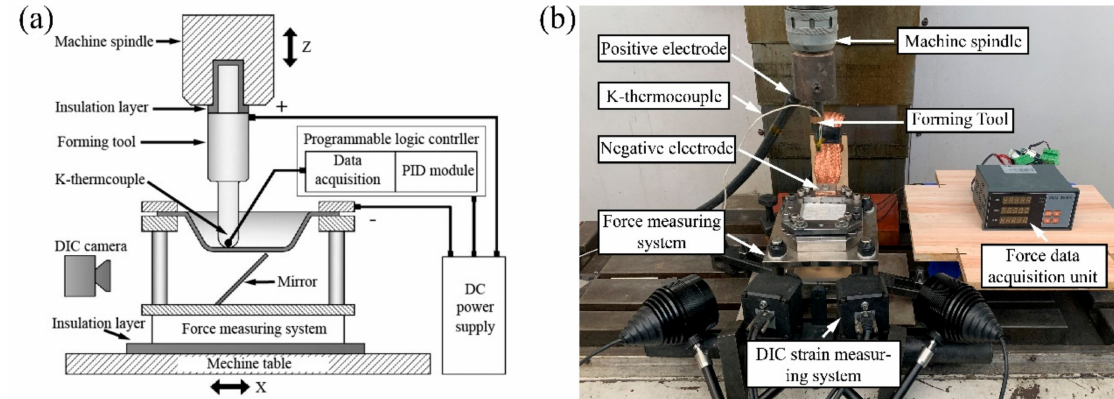
Figure 2. Experimental equipment of EHIF: ( a ) schematic structure, ( b ) actual setup. The tool path was controlled by the NC program in the FANUC system as shown in Figure 3a. The horizontal and vertical feeds of the machine corresponded to the X and Z directions, respectively. The length of the straight groove was 60 mm and the processing parameters were a step size of 0.2 m, a feed rate of 500 mm/min and a tool diameter of 8 mm. The target temperatures of the tool were set to 100 ◦ C, 150 ◦ C, 200 ◦ C, 250 ◦ C, 300 ◦ C and 350 ◦ C. The experiment was repeated three times under each condition. In order to study the temperature variation during the machining path, the actual temperature of the plate was measured at point A, B and C, as shown in Figure 3b, to compare with the target tool temperatures. Based on the digital image correlation (DIC) strain measuring system (Module XJTUDIC, Xi’an, China), the strain distribution of groove specimens was obtained. The forming force data were acquired by the measuring system, which consisted of the data acquisition card and the personal computer (PC). The mixture of MoS 2 power and acetone solution was applied as the lubricant to reduce the friction between the tool and sheet. The microstructure was observed by the optical microscope (Module Axio Lab A, Jena, Germany) and the fracture behavior was analyzed by the scanning electron microscope (SEM, Module Nova Nano SEM 450, Hillsboro, OR, USA). Microhardness measurement was carried out with the Vickers hardness testing machine (ModuleMHV-